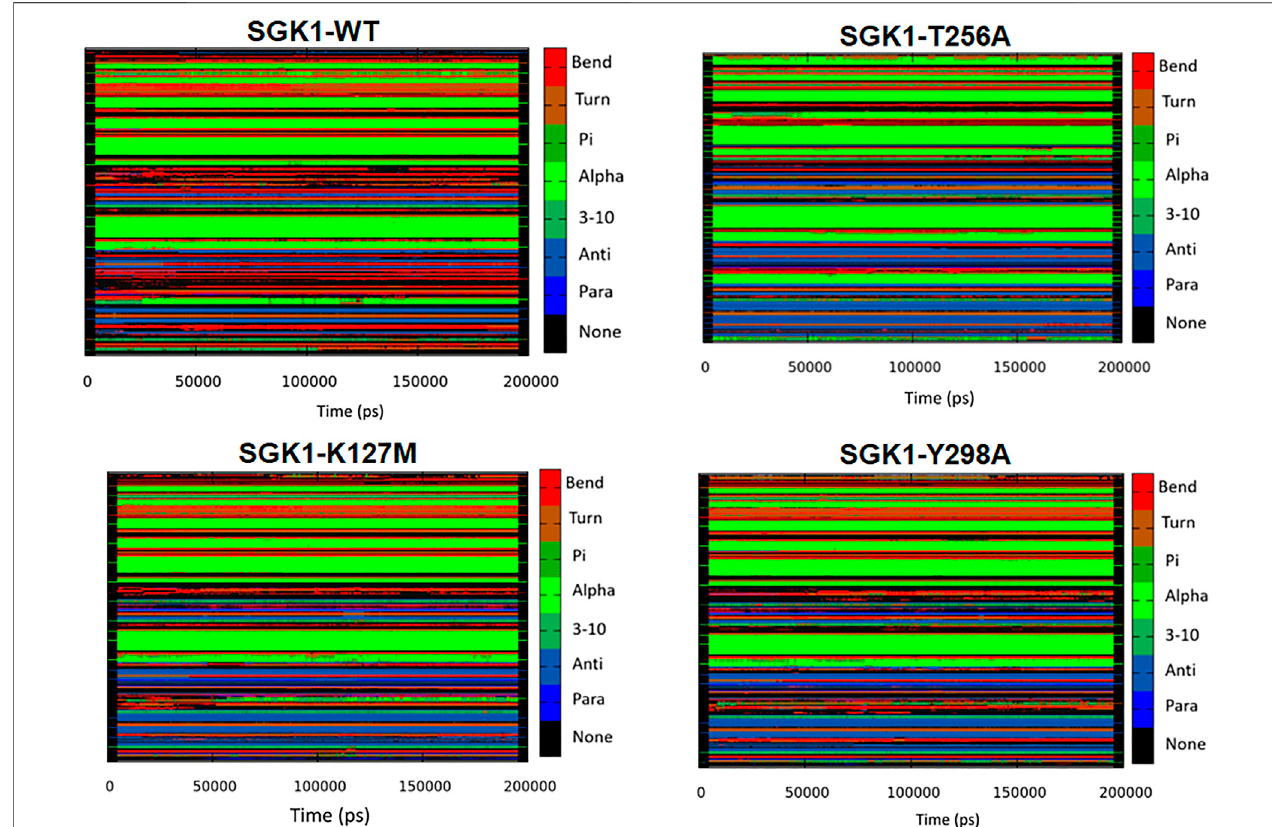
Frontiers in Molecular Biosciences |